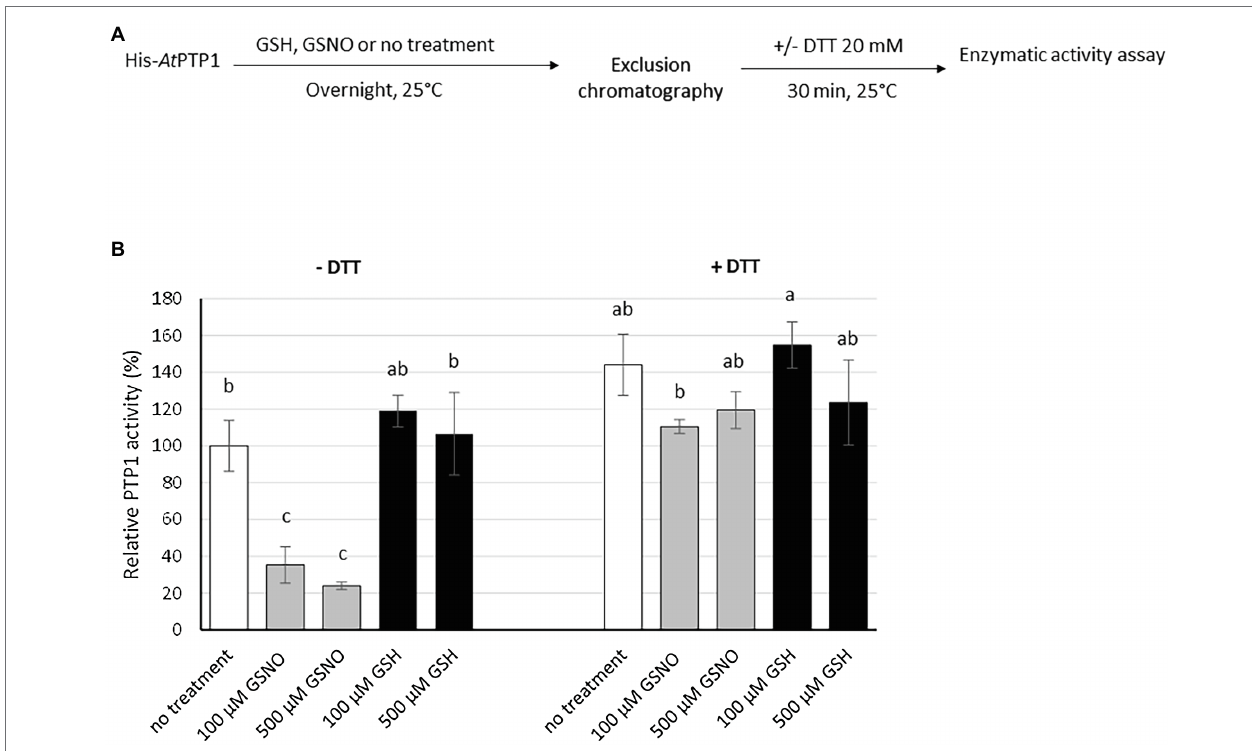
FIGURE 3 | Effect of GSH or GSNO treatment on His- At PTP1 activity in the absence or presence of DTT. (A) Experimental design. (B) Measurement of the enzymatic rate of His- At PTP1 following treatment with 100 or 500 μ M of GSNO (grey columns) or GSH (black columns) in the absence or presence of 20 mM DTT. Following the treatment, GSH or GSNO was removed through exclusion chromatography. Results are expressed relative to the enzyme activity measured without GSH/GSNO or DTT treatments. Values are means of four measurements ±SEM. The results shown are from one representative experiment among three independent experiments. Significant differences are denoted by different letters ( p ≤